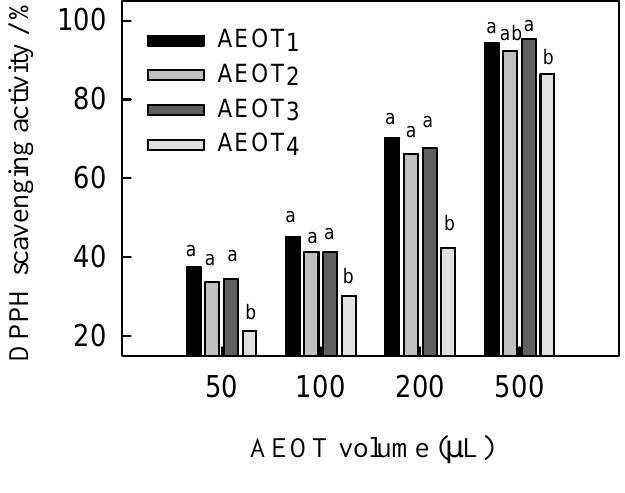
Figure 1 . Effects of AEOT under different steeping conditions at various concentrations of oolong tea aqueous infusion on the DPPH radical scavenging activity. Different letters indicate significant differences between treatments according to Tukey multiple comparisons ( p